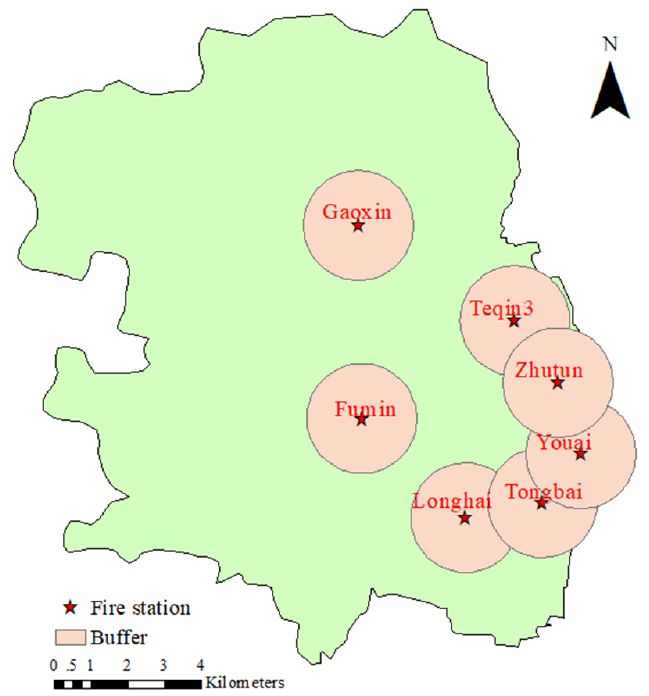
Figure 1. Protection scope of existing fire stations.